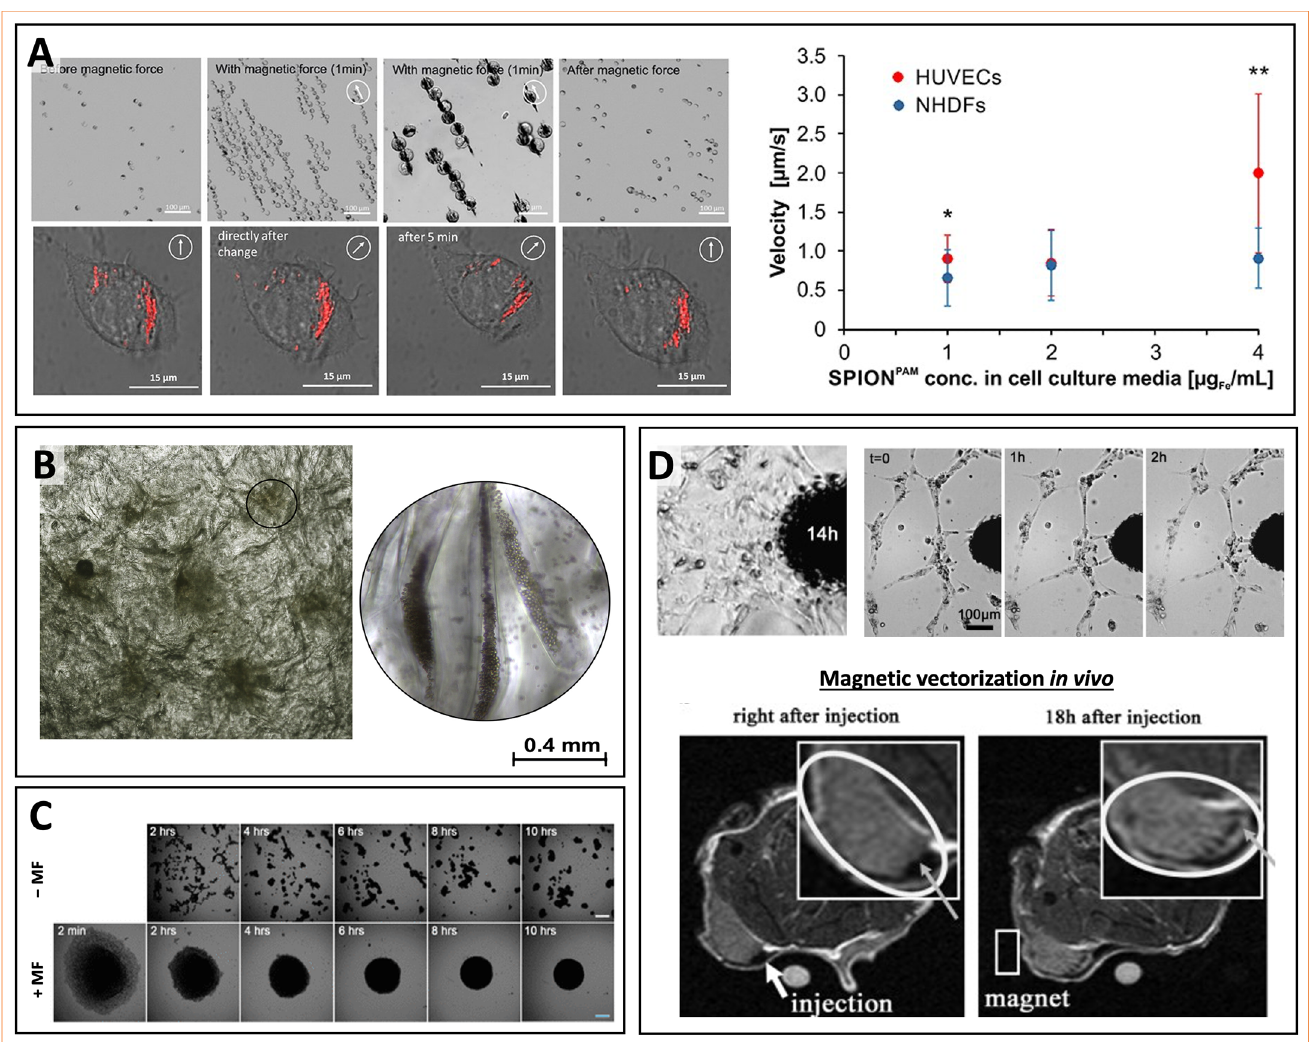
Figure 7. Magnetic guidance of cells . ( A ) Magnetic guidance for the formation of aligned cell clusters that are largely reversible upon removal of the magnet system. Magnetically induced velocities of SPION-labeled fibroblasts, endothelial cells, and cell clusters, guided on a square path by changing the direction of the quadrupole. Statistical significances between SPION-loaded HUVEC and NHDF cells are indicated with * and **. The respective confidential intervals are p ≤ 0.05 and p ≤ 0.0005, respectively, and were calculated via Student’s t -test. Confocal laser microscopy of macrophages labeled with fluorescent SPIONs guiding the intracellular organization of SPION-loaded endosomes upon varying magnet orientations. Adapted and Reproduced with permission from Ref. [245]. ( B ) Photograph of a scaffold seeded with magnetic Mesenchymal Stem Cells (MSCs), under the influence of the magnetic fields created by the tips. Magnetic fields induced precise cell patterning creating hexagonal multicellular assemblies within the scaffold. Adapted and Reproduced with permission from Ref. [251]. ( C ) Formation of pre-adipocyte cell spheroids in the presence (+MF) and absence (-MF) of an applied magnetic field over time (scale bars: 300 µ m). Adapted and Reproduced with permission from Ref. [108]. ( D ) Top: endothelial cells magnetized with MNPs form dense tissue around the magnetic tip 14 h after seeding onto Matrigel, and ex novo formation of tubular structures connecting to the magnetic tip in 2 h. Bottom: MRI of in vivo guidance of magnetized endothelial cells injected into Matrigel, implanted subcutaneously in mice. After 18 h of application of gradient magnetic field, negative enhancement is diluted on Matrigel submitted to the magnet, whereas controls still show a localized area of hypointense signal (not shown). Adapted and reproduced with permission from Ref.